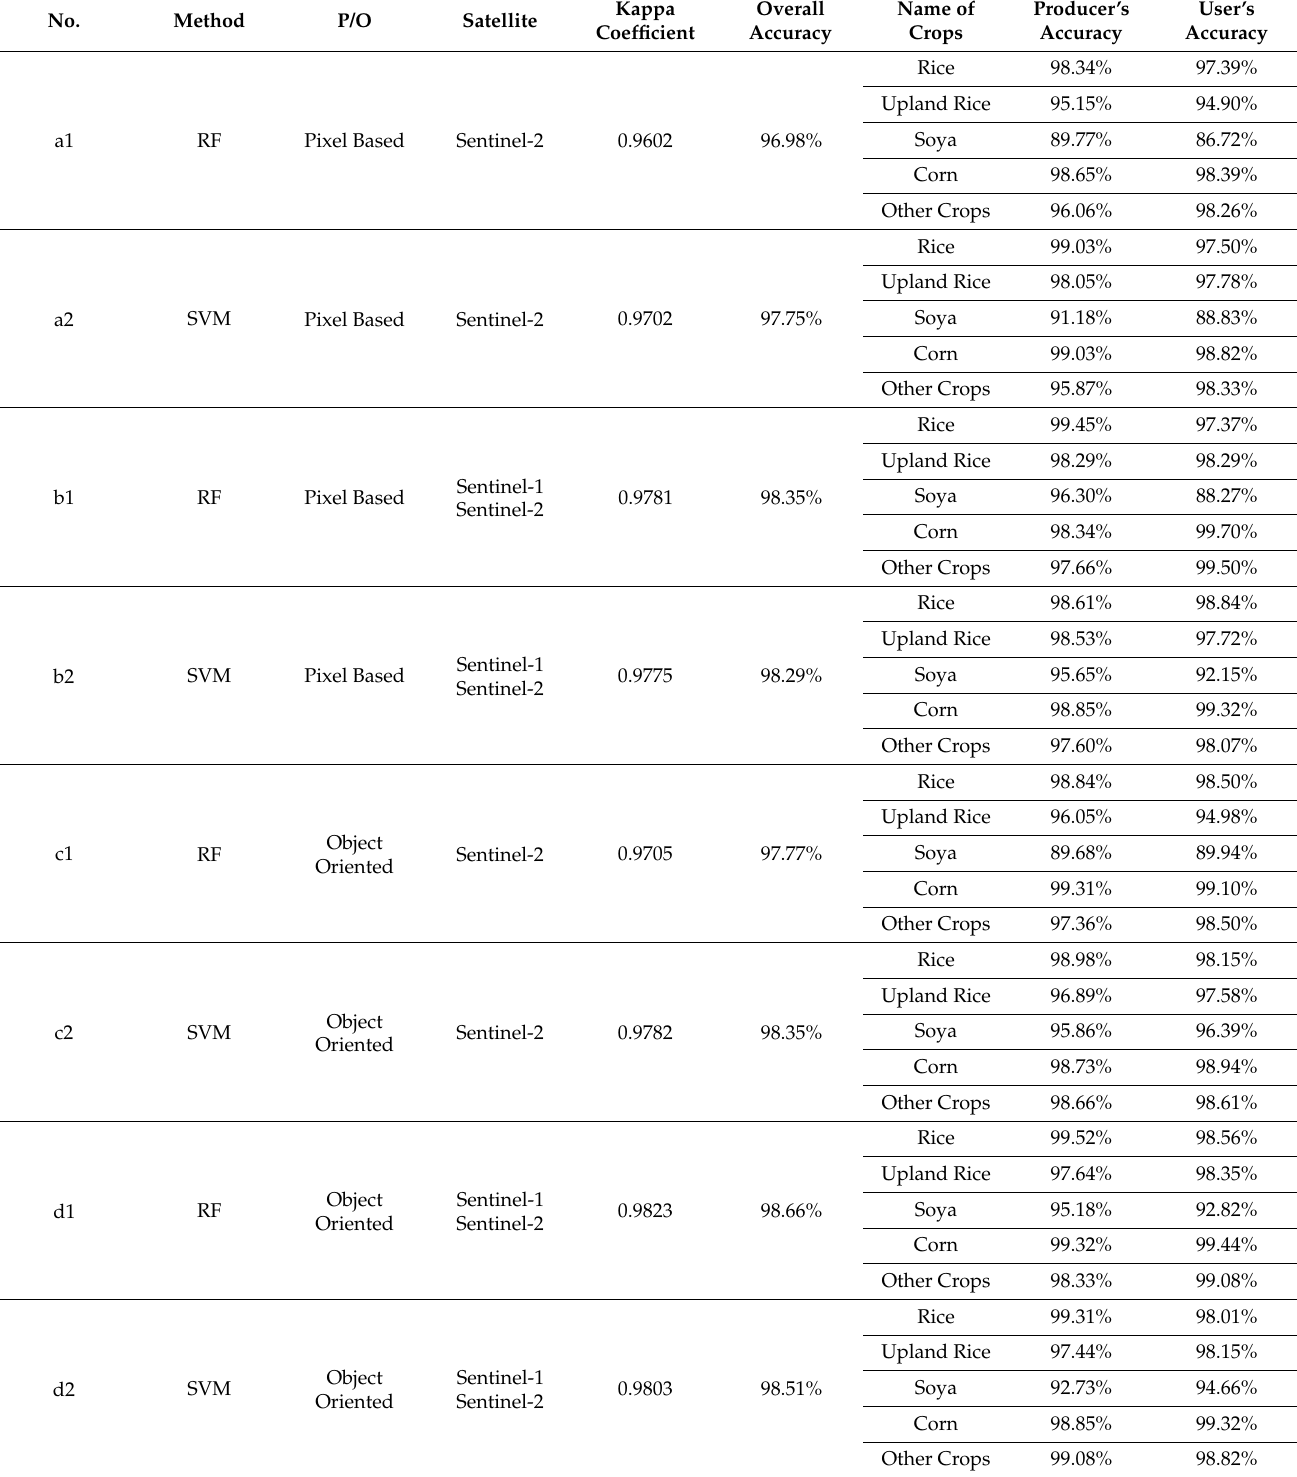
Table 5. Summary of the